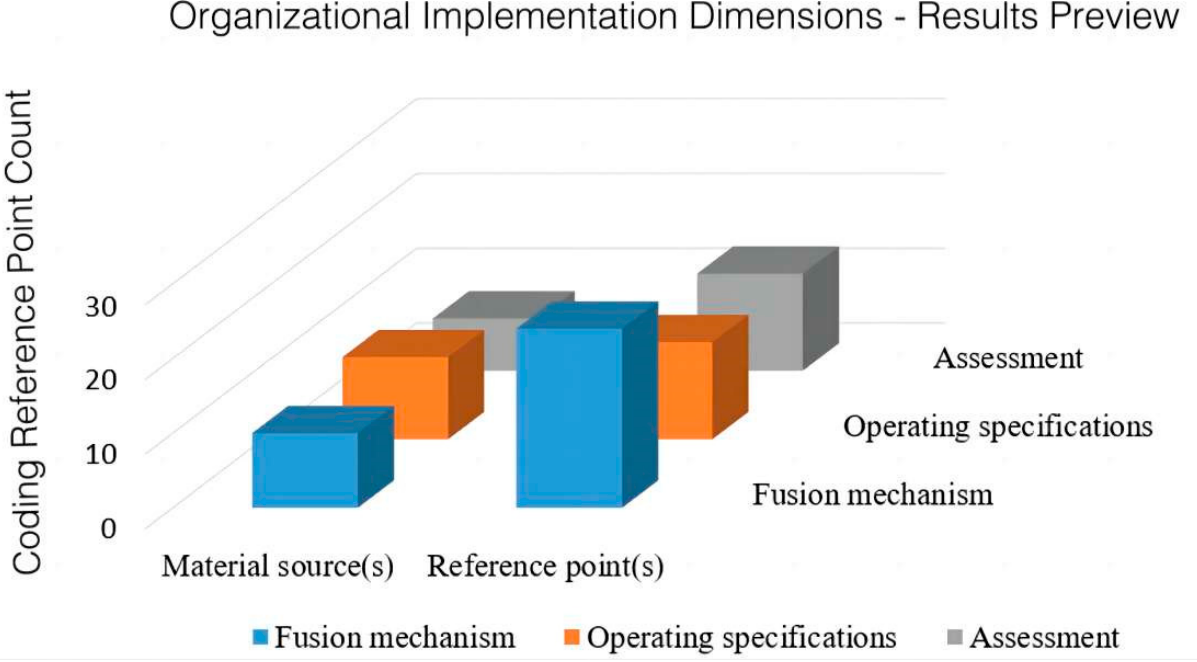
Figure 5. Distribution of reference points for the organization and implementation of the integration of sports and medicine policy.